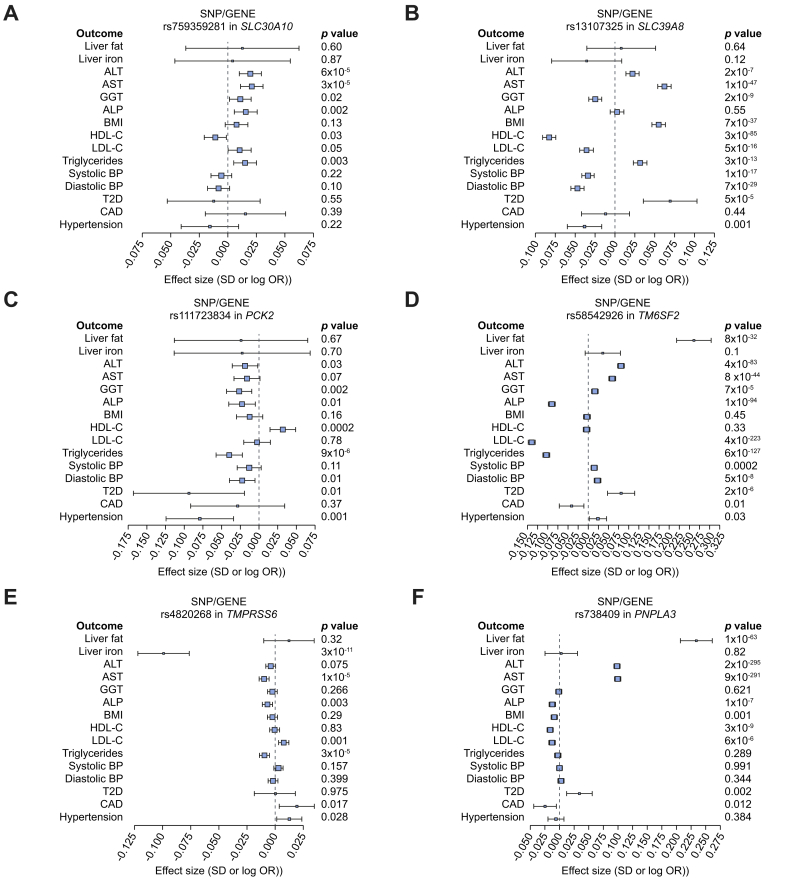
Forest plot of the associations of liver cT1 variants with liver and metabolic phenotypes.Effects are in SD for continuous traits and log(OR) for disease outcomes per copy of the risk allele. A linear mixed model was used for genetic associations. Levels of significance: p <0.05. ALP, alkaline phosphatase; ALT, alanine aminotransferase; AST, aspartate aminotransferase; CAD, coronary artery disease; cT1, corrected T1; GGT, gamma-glutamyltransferase; HDL-C, HDL-cholesterol; LDL-C, LDL cholesterol; OR, odds ratio; T2DM, type 2 diabetes.